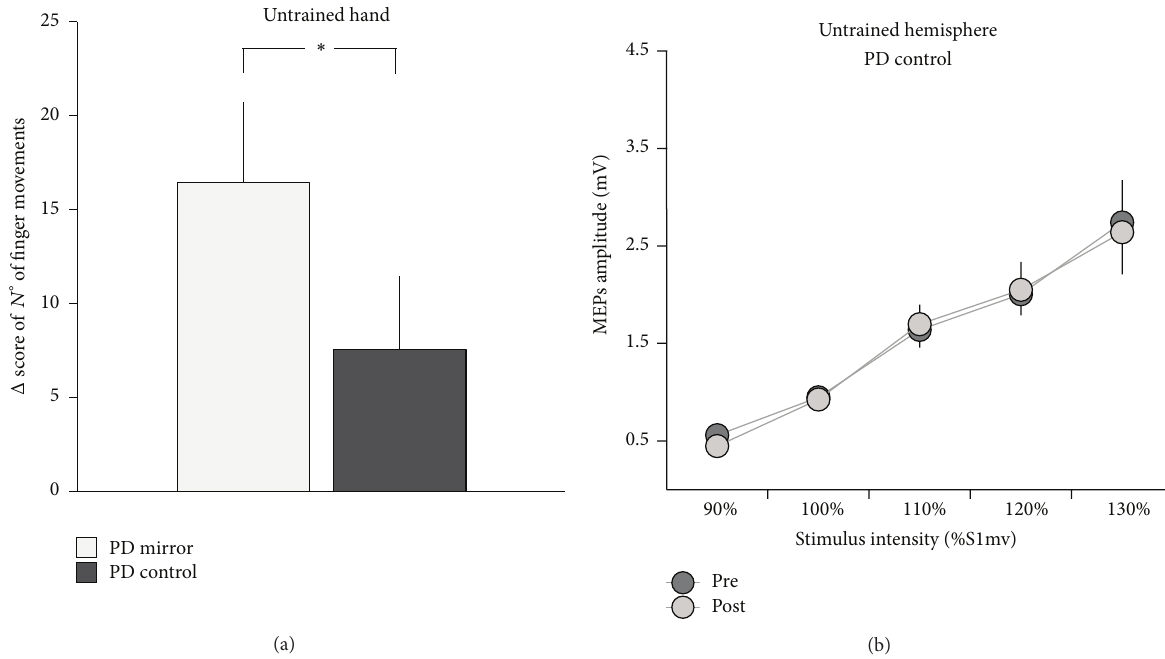
Figure 6: Data from the control experiment (training without MVF). (a) shows the behavioural data, expressed as performance gain ( Δ score of the numbers of finger movements performed in one minute) in the untrained hand of PD patients enrolled in the main experiment (PD mirror) and PD patients enrolled in the control experiment (PD control). In (b) the Input-Output (IO) curves of the untrained M1 of the PD control group, before and after training, are depicted. MEP amplitudes, in mV, are depicted from 90% to 130% S1mV (the stimulus intensityneededtoevokeMEPsofapproximately0.8 − 1 mVpeak-to-peakamplitude).Verticalbarsindicatestandarderrorofthemean(SEM). ∗ 𝑝 < 0.05